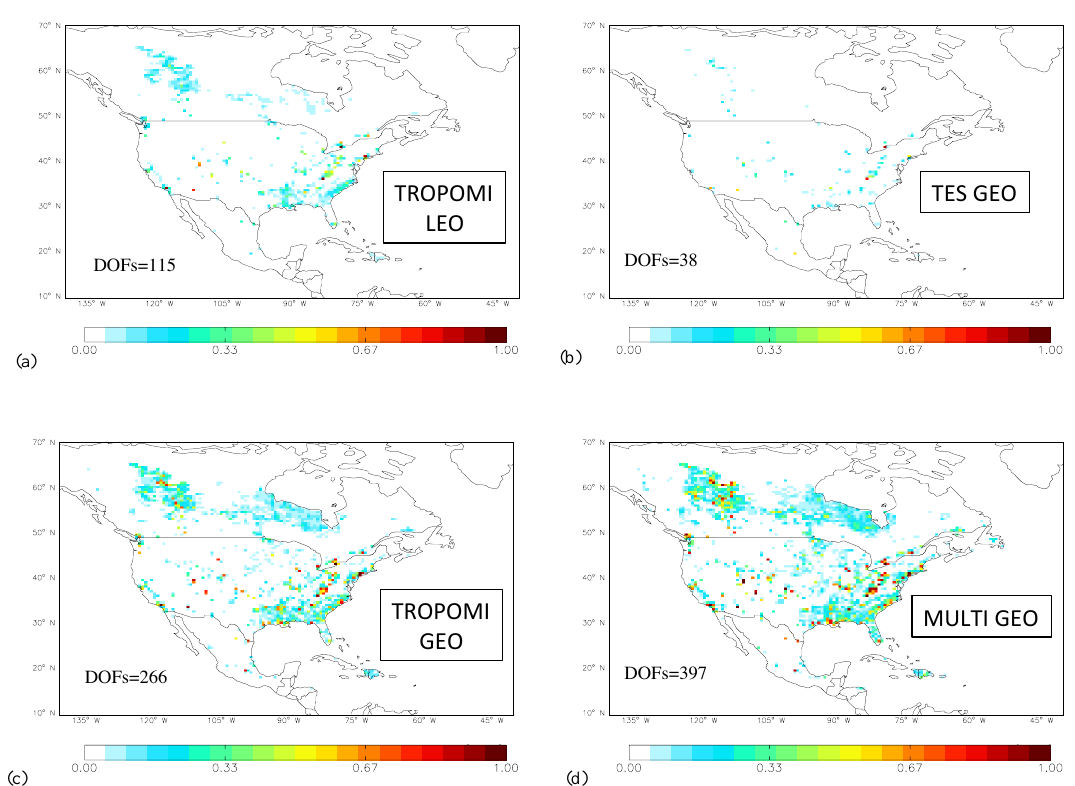
Figure 6. Relative error variance reduction for a 3-day methane emission optimization (1–3 July 2008) using (a) TROPOMI low-Earth orbit observations (TROPOMI_LEO); (b) GEO-CAPE observations with a TES-like instrument (TES_GEO); (c) GEO-CAPE observations with a TROPOMI-like instrument (TROPOMI_GEO); and (d) GEO-CAPE observations with a multi-spectral instrument (MULTI_GEO). Zero values correspond to emissions with no constraints from observations, while values of one correspond to emissions entirely constrained by observations. The DOF for each inversion, which is the sum of all diagonal elements of the model resolution matrix, is also